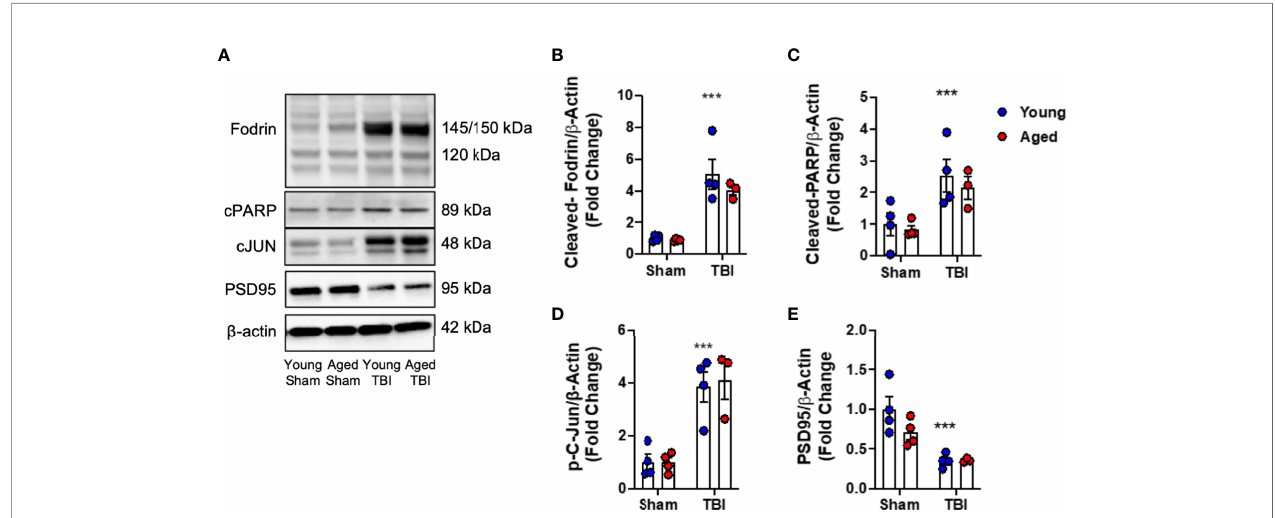
FIGURE 1 | DNA damage, cell death and neuroplasticity markers in the injured cortex of young and aged mice. Western blot expression of cleaved-Fodrin (B) , cleaved-PARP (C) , phospho-c-Jun (D) and PSD95 (E) protein in the ipsilateral cortex young and aged Sham and TBI mice at 24 hours post-injury. Representative Western blots are shown in (A) TBI signi fi cantly increased cortical expression of cleaved-Fodrin (p<0.0001, B ), cleaved-PARP (p=0.0075, C ) and phosphor-c-Jun (p<0.0001, D ) protein in young and aged mice. There was no effect of age on protein expression. TBI signi fi cantly decreased protein expression PSD95 (p<0.0001, E ). There was no effect of age on PSD95 protein expression. Data expressed as Mean ± SEM. ***p < 0.001 vs. sham (effect of TBI). Two-way ANOVA using Tukey post-hoc tests